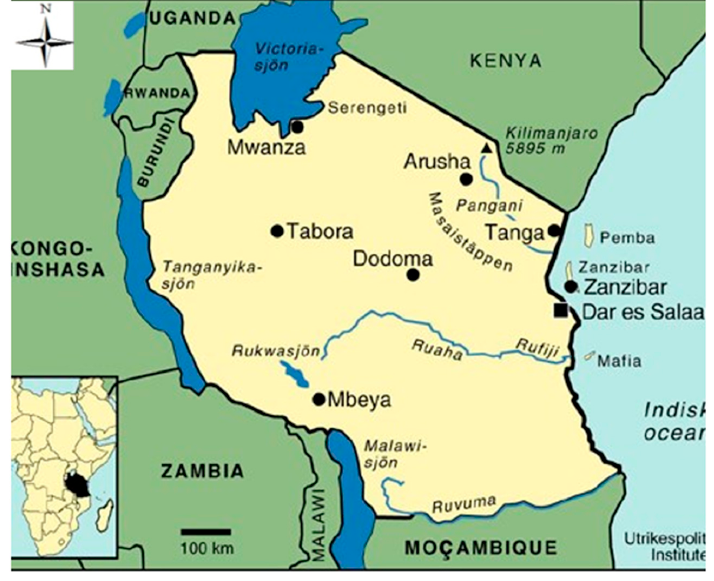
Figure 1. Map of Tanzania and its borders [22].